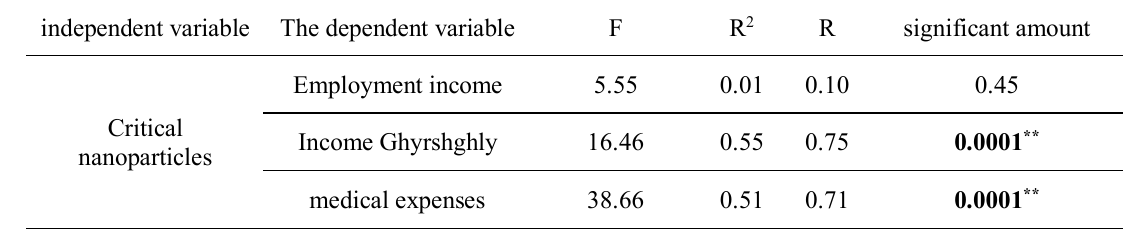
Table 3. Evaluation of the effect of nanoparticles on the variable Petrochemical crisis in mental health personnel, quality of work life of employees and employee participation